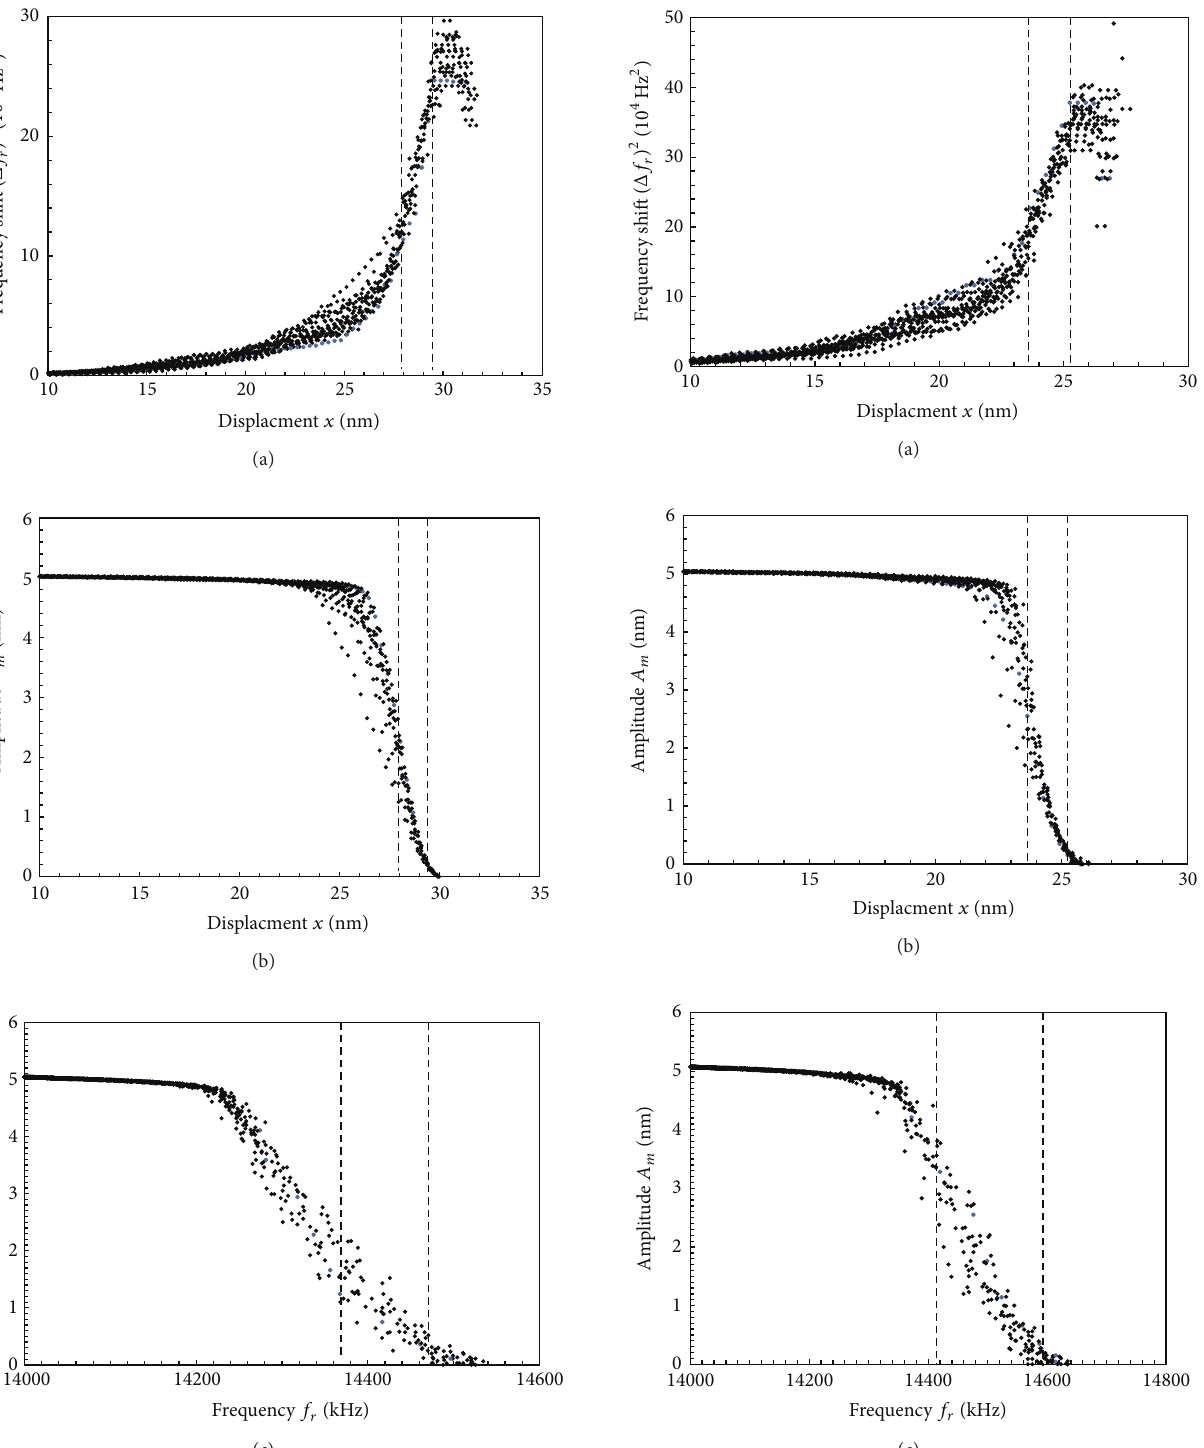
Figure 3: (a) The square of the resonant frequency shift ( Δ𝑓 𝑟 ) 2